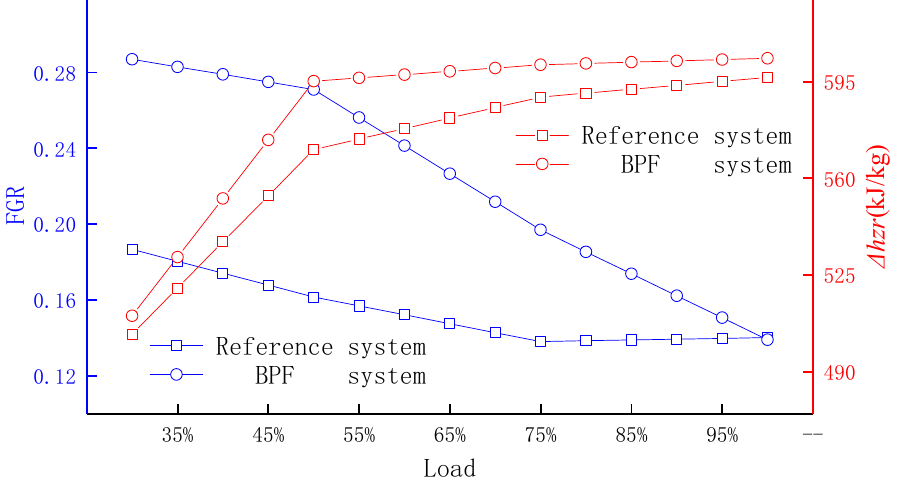
Figure 13. FGR and ∆ h zr change of reference system and cuto ff bypass Figure 13. FGR and Δ h zr change of reference system and cutoff bypass system.